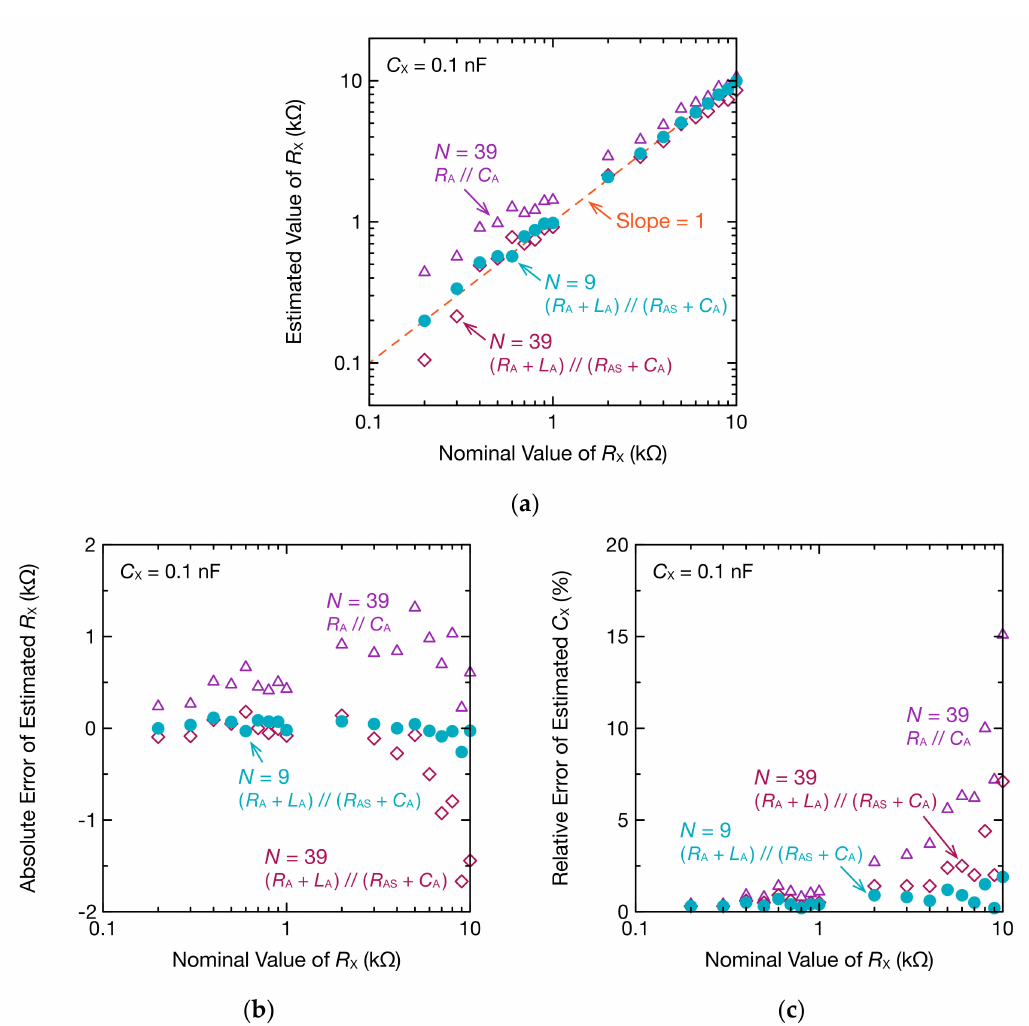
. Z A : ( a ) estimated R X ; ( b ) absolute error of estimated